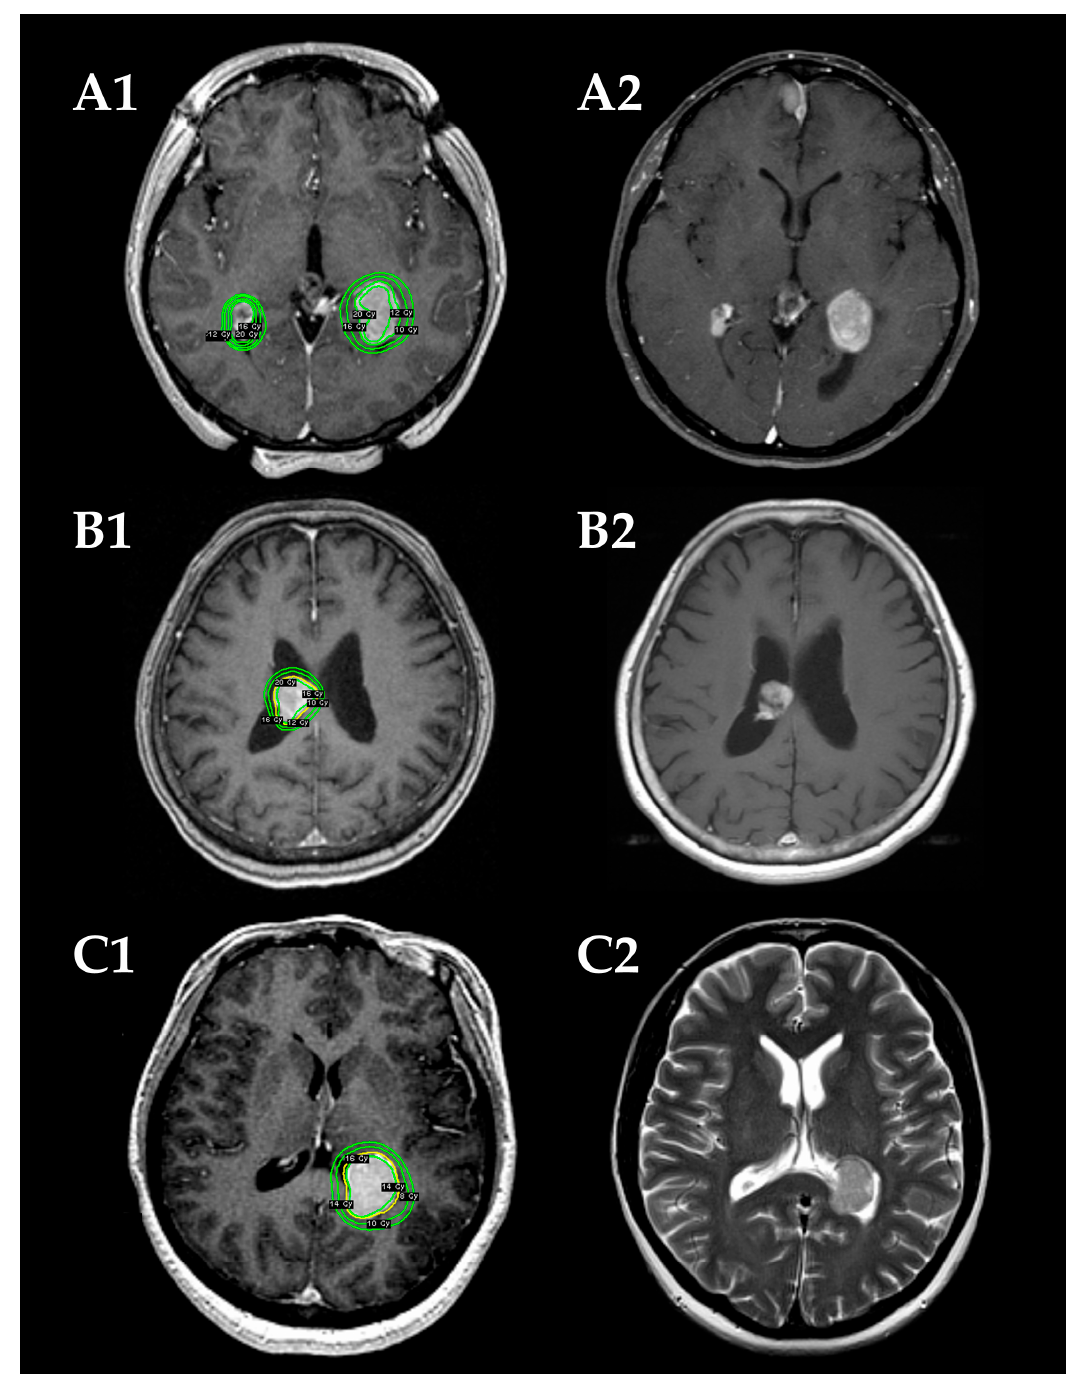
Figure 1. Radiosurgical plans ( A1 – C1 ) and follow-up magnetic resonance images (MRIs) ( A2 – C2 ) in three demonstrative patients. ( A ) A 31-year-old woman with NF2-related bilateral intraventricular meningiomas (IVMs) in the trigones of the lateral ventricles (cases 7 and 8). The tumors are stable in size on a follow-up MRI at 21 months after the stereotactic radiosurgery (SRS). ( B ) An 80-year-old woman with a sporadic IVM in the body of the right lateral ventricle (case 9). Tumor shrinkage is confirmed on a follow-up MRI at 109 months after the SRS. ( C ) A 50-year-old woman with a sporadic IVM in left trigone (case 11). Tumor shrinkage is confirmed on a follow-up MRI at 35 months after the